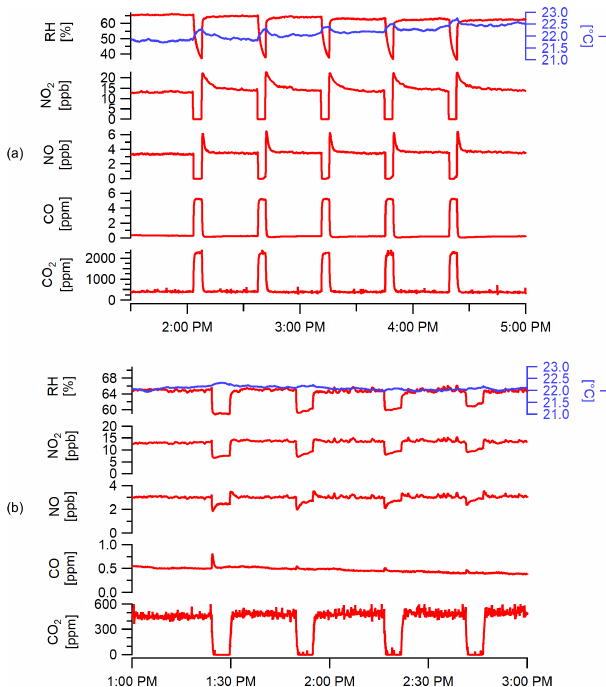
Figure 11. Performance of the onboard calibration system over se- quential cycles (for demonstration) showing (a) the span gas deliv- ery for CO and CO 2 (and zero air to provide zero concentrations for NO and NO 2 ) over five repeated cycles and (b) the zeroing function for CO 2 over four cycles where other signals are shown to illustrate minimal changes with zero trap (NO x changes are due to shown RH changes). PM zeroing function results are shown in Fig.